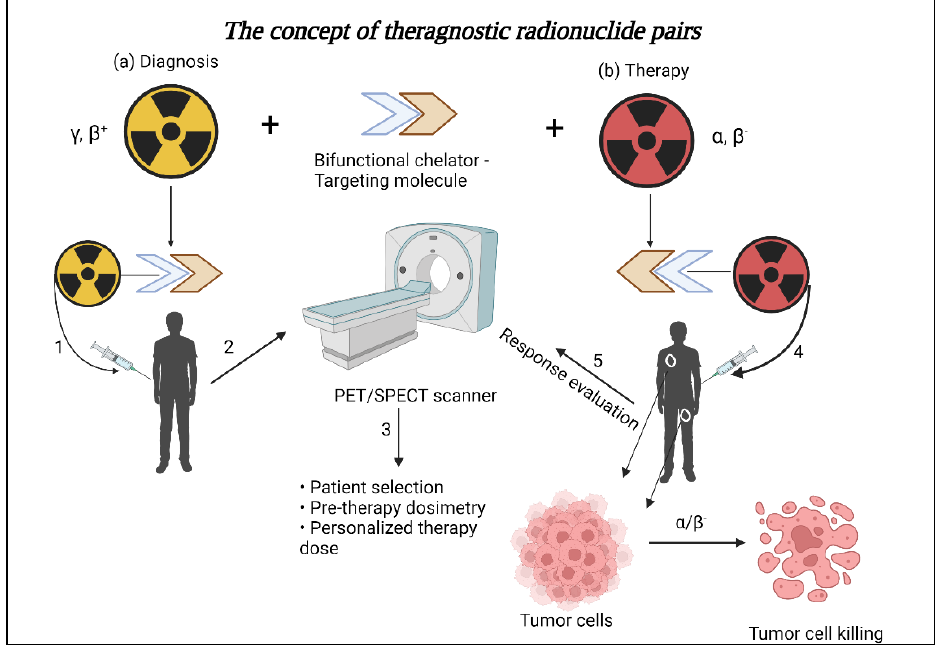
Figure 1. The schematic shows the concept of theragnostic pairs. Targeting molecule conjugated with a bifunctional chelator (BFC) and radiolabeled with a diagnostic radionuclide (gamma/positron (γ/β + ) emitting) is injected into the patient (1). Molecular imaging is performed using positron emission tomography (PET) or single photon emission computed tomography (SPECT) to identify lesions (2). Patient selection is made based on scan findings, and pre−therapy dosimetry is performed to calculate personalized therapy dose. (3). For therapy, the same BFC−targeting molecule tagged with a therapeutic radionuclide is injected into the patient (4). Alpha/beta particles (α/β − ) cause the tumor cell killing, and response evaluation is done with molecular imaging (5). Created with BioRender.com, accessed on 25 September 2022.